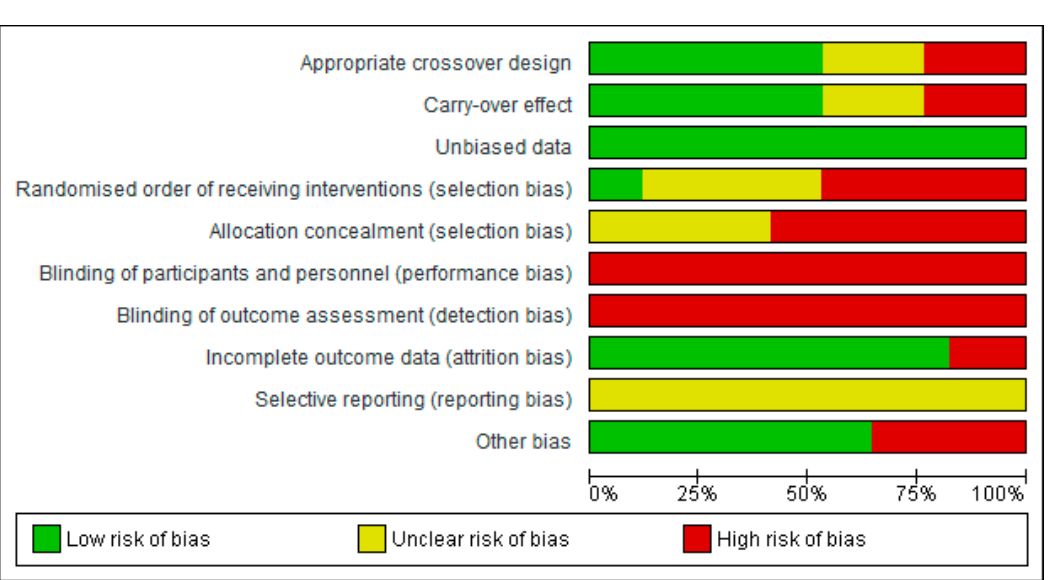
Table 3. The longitudinal effects of outdoor green exercise versus indoor exercise on emotions and enjoyment: meta-analysis of parallel RCTs .